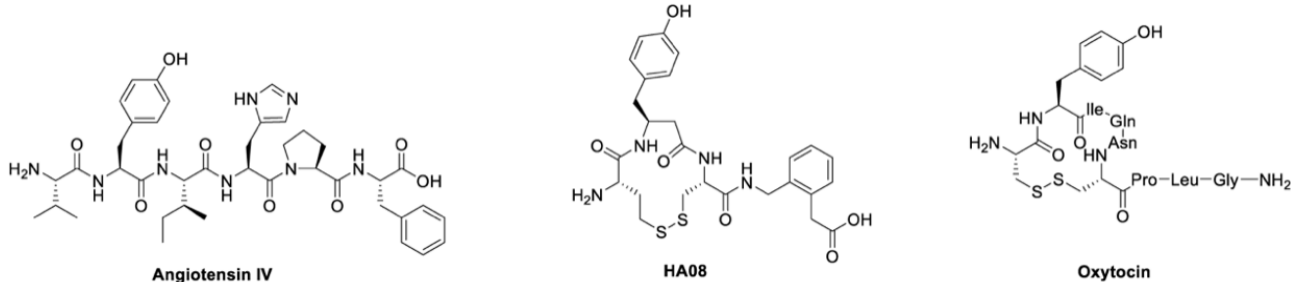
Figure 1. Chemical structures. The chemical structures of the endogenous IRAP inhibitor and cog- nitive enhancer angiotensin IV, the potent synthetic IRAP inhibitor HA08 and the IRAP substrate oxytocin